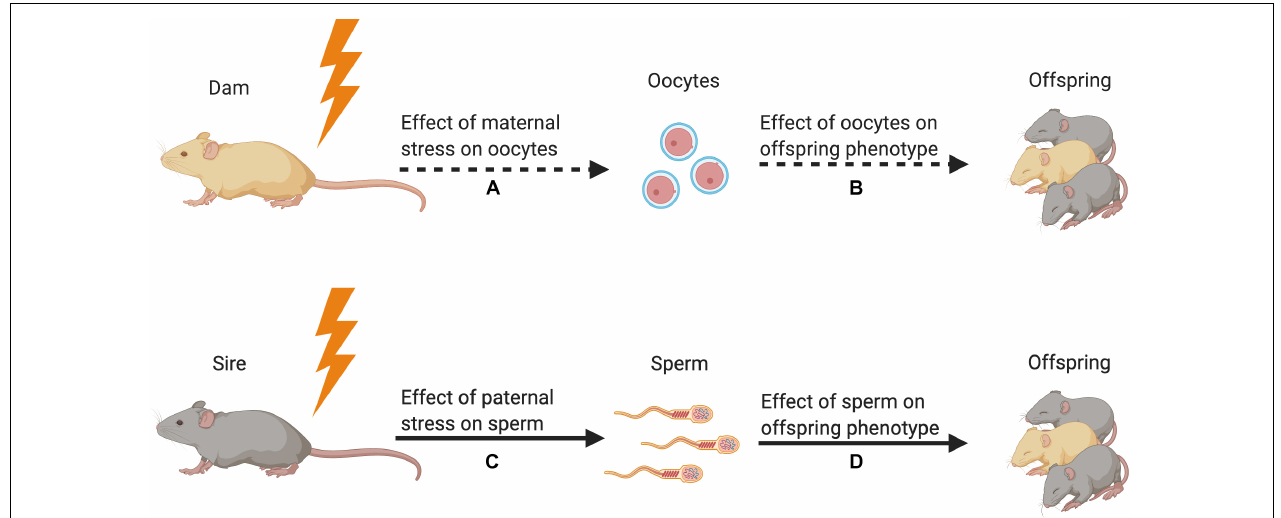
FIGURE 1 | Strength of the evidence for germline transmission of parental stress on offspring phenotype in animal models. (A) Only one study has demonstrated an effect of maternal preconception stress on oocytes (Zaidan et al., 2013). This study showed that stress increased corticotropin releasing factor type 1 messenger RNA but did not reveal a change in epigenetic signals. (B) No studies have tested for the effect of stress-induced oocyte epigenetic changes on offspring phenotype. (C) Many studies have demonstrated that paternal preconception stress affects sperm DNA methylation and small non-coding RNA content (Franklin et al., 2010; Rodgers et al., 2013; Gapp et al., 2014, 2016; Bohacek et al., 2015; Wu et al., 2016; Chan et al., 2020). (D) Multiple studies have used in vitro fertilization, intracytoplasmic sperm injection, and microRNA microinjection to demonstrate that stress-induced alterations in sperm sncRNA content affect offspring